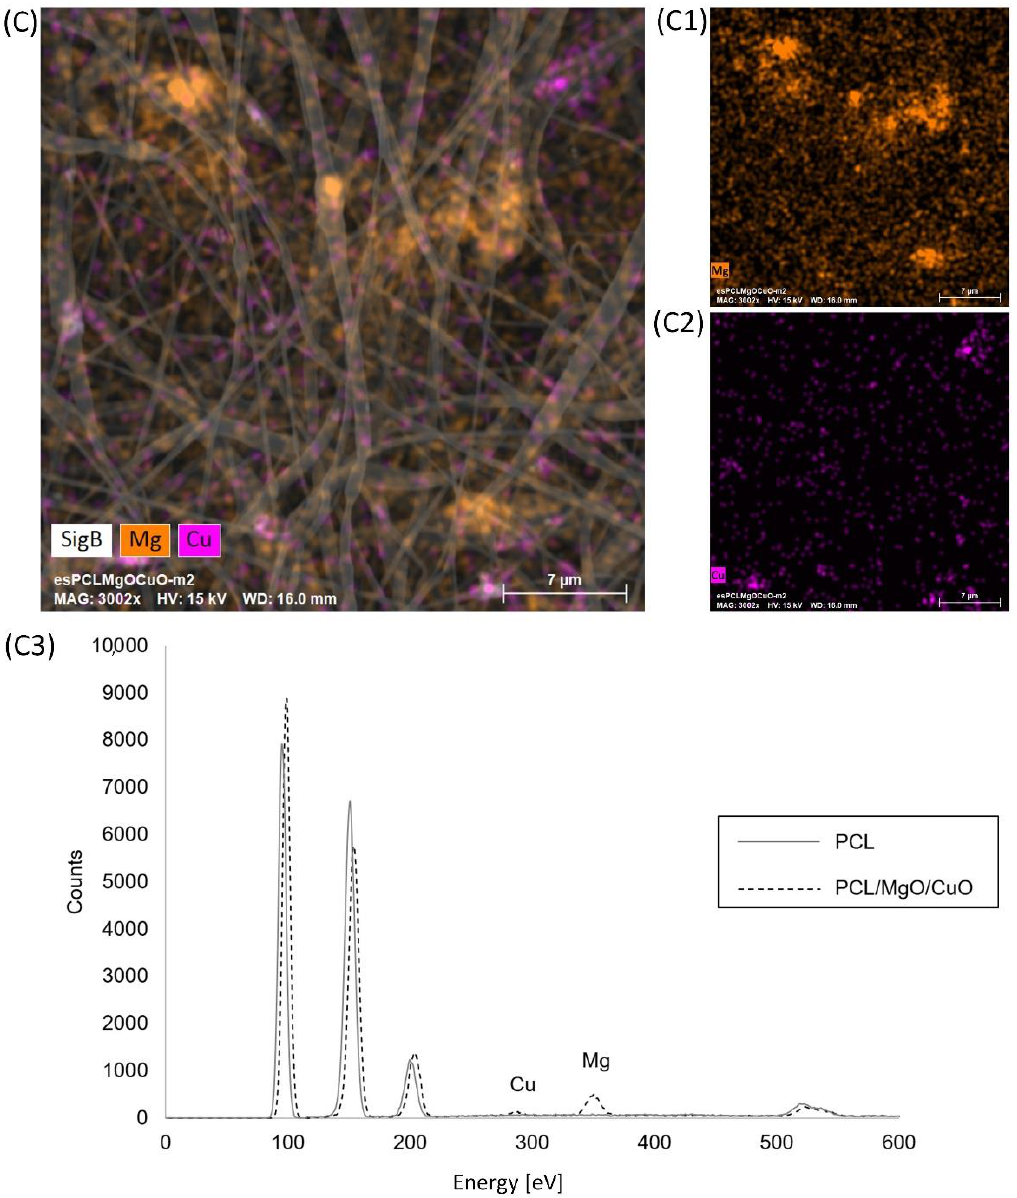
Figure 4. Scanning electron microscopies of PCL electrospun meshes and respective average fiber diameters with the distribution curve ( A ). PCL electrospun meshes dopped with MgO and CuO NPs with the average fiber diameters and its distribution curve ( B ). Statistical significance for p ≤ 0.05 (*). ( C ) EDX mapping combined with SEM image of PCL electrospun meshes dopped with MgO and CuO NPs (orange: MgO NP ( C1 ); purple: CuO NP ( C2 )), ( C3 ) EDX spectrum of PCL-free and non-free MgO and CuO